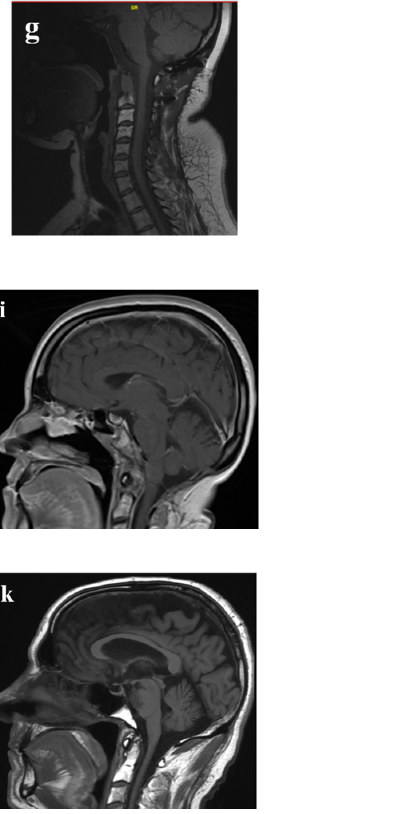
Figure 3. Magnetic resonance imaging (MRI) of five illustrative clival chordoma cases which required a different surgical strategy. ( a ) The first case is a holoclival chordoma (maximal diameter, 5 cm), which was resected by endoscopic endonasal approach (EEA). Preoperative T1-weighted (T1) fluid attenuated inversion recovery (FLAIR) sagittal MRI shows a clival mass displacing the pituitary gland and the brainstem; ( b ) The near total resection was attained by EEA. Enhanced T1 3D fast spin echo fat suppressed sagittal MRI in 3 years shows no recurrent tumor; ( c ) The second case is a holoclival chordoma (maximal diameter, 5 cm), which was resected by EEA after an occipito-cervical fusion (two stages). Preoperative enhanced T1 sagittal MRI shows a clival mass; ( d ) It was eroding the left occipital condyle (not shown) and an occipito-cervical fusion was done before EEA. Enhanced T1 fat suppressed sagittal MRI in 2.5 years shows no signs of recurrence; ( e ) The third case is a holoclival chordoma (maximal diameter, 8.8 cm), which was resected by endoscopic transcervical approach. Preoperative enhanced T1 fat suppressed sagittal MRI shows a clival mass extending as low as periodontoid space; ( f ) This case underwent two EEA and occipito-cervical fusion in an outside hospital. Enhanced T1 sagittal MRI shows a residual mass in the periodontoid space; ( g ) The subtotal resection was attained. T1 fast spin echo sagittal MRI in 1.5 years shows a stable residual mass; ( h ) The fourth case is a lower clival chordoma (maximal diameter, 4.3 cm), which was resected by EEA and open craniotomy. Preoperative enhanced T1 fast spin echo sagittal MRI shows an enhancing lobulated mass compression the cervicomedullary region; ( i ) EEA showed that the tumor was firm and arachnoid scarring was appreciated. One month after EEA, open tumor resection was done by right far lateral supracondylar craniotomy and C1 laminectomy (near total resection). Enhanced T1 spin echo sagittal MRI in about 8 years shows no signs of recurrence; ( j ) The last case is a holoclival chordoma (maximal diameter, 4.4 cm), which was resected by upfront open surgery. Preoperative enhanced T1 fat suppressed sagittal MRI shows an enhancing clival lobulated mass displacing the brainstem; ( k ) An open resection by left presigmoid subtemporal craniotomy with posterior petrosectomy was done (subtotal resection). T1 FLAIR sagittal MRI in 2.5 years shows a stable residual